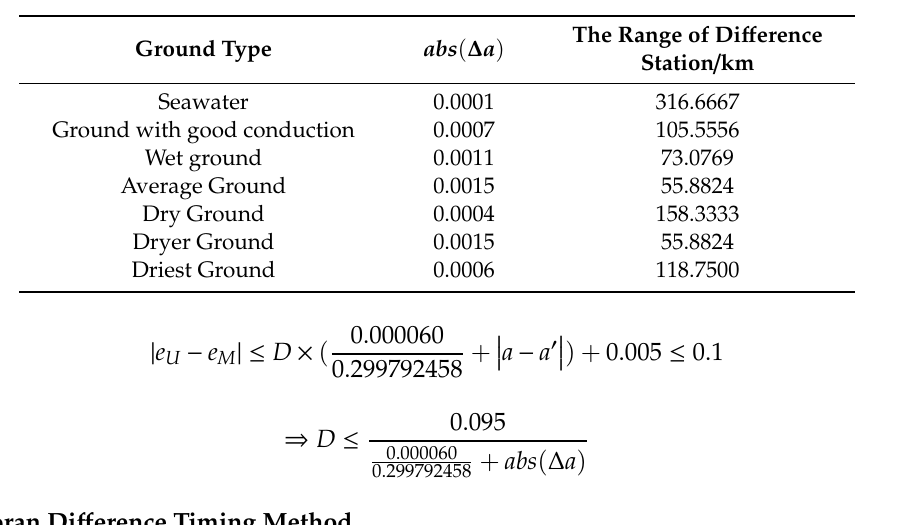
Table 5. Scope of di ff erence station in a typical